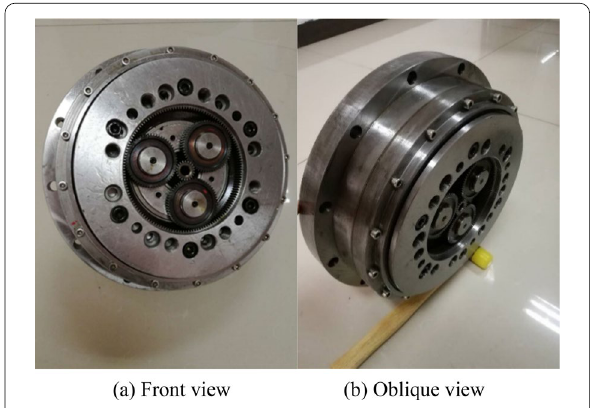
Figure 19 Temperature rise of no-load